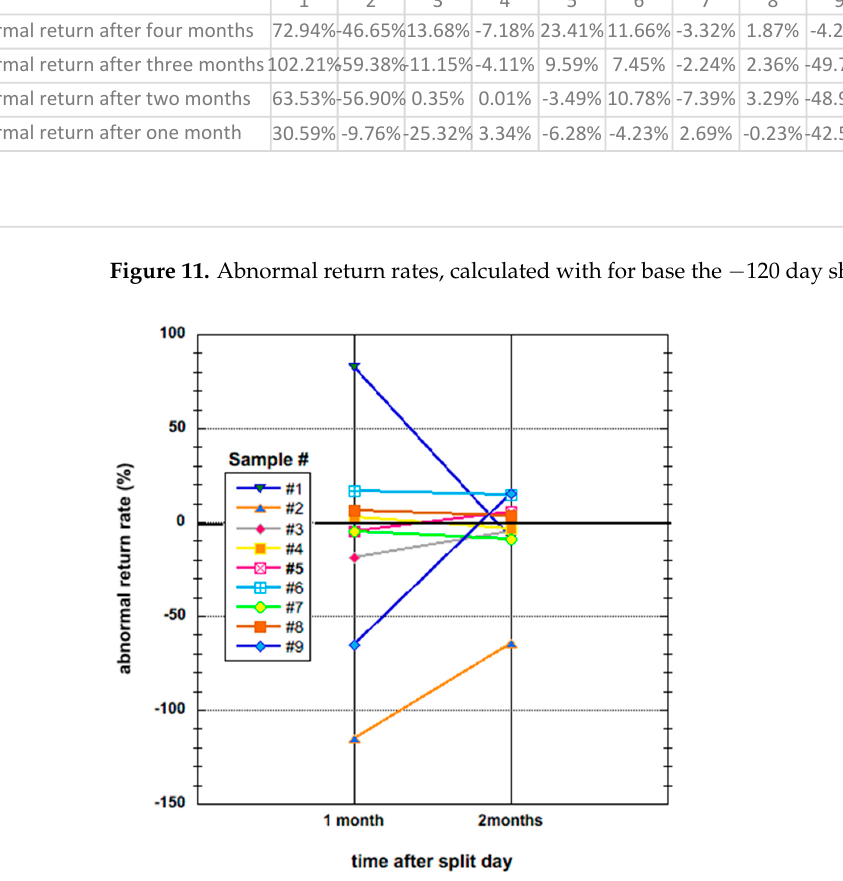
Figure 12. Abnormal return rate after two months and after one month with respect to virtual demarcation day. Table 4. Abnormal return rate with virtual demarcation day.